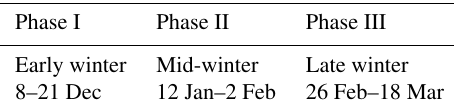
Table 1. POLSTRACC mission